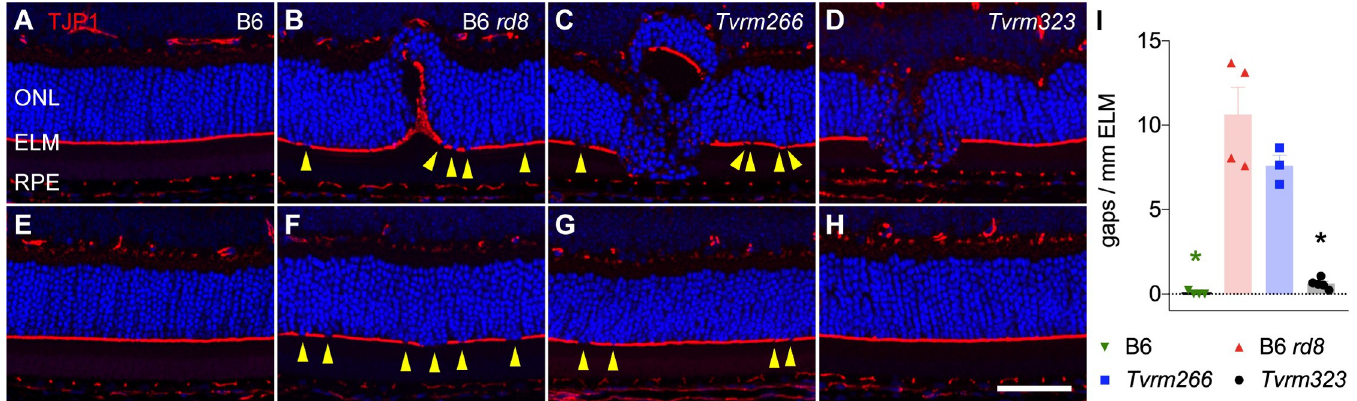
Fig 7. ELM fragmentation in modifier strains. Retinal sections from mice at one month of age were stained with antibodies against TJP1 ( red ) to detect the ELM and DAPI ( blue ) to detect nuclei. A–D. Inferior retina. E–H. Superior retina. A, E, B6; B, F, B6 rd8 ; C, G, Tvrm266 ; D, H, Tvrm323 . Gaps are indicated by yellow arrowheads . Images are representative of n = 8 samples from each strain. H. Scale bar, 50 μ m, applies to all image panels. I. Count of gaps over the full length of ELM except at dysplastic lesions, normalized to ELM length (n = 3–4). Bars indicate mean ± SEM. Asterisks , p < 0.0001, post hoc